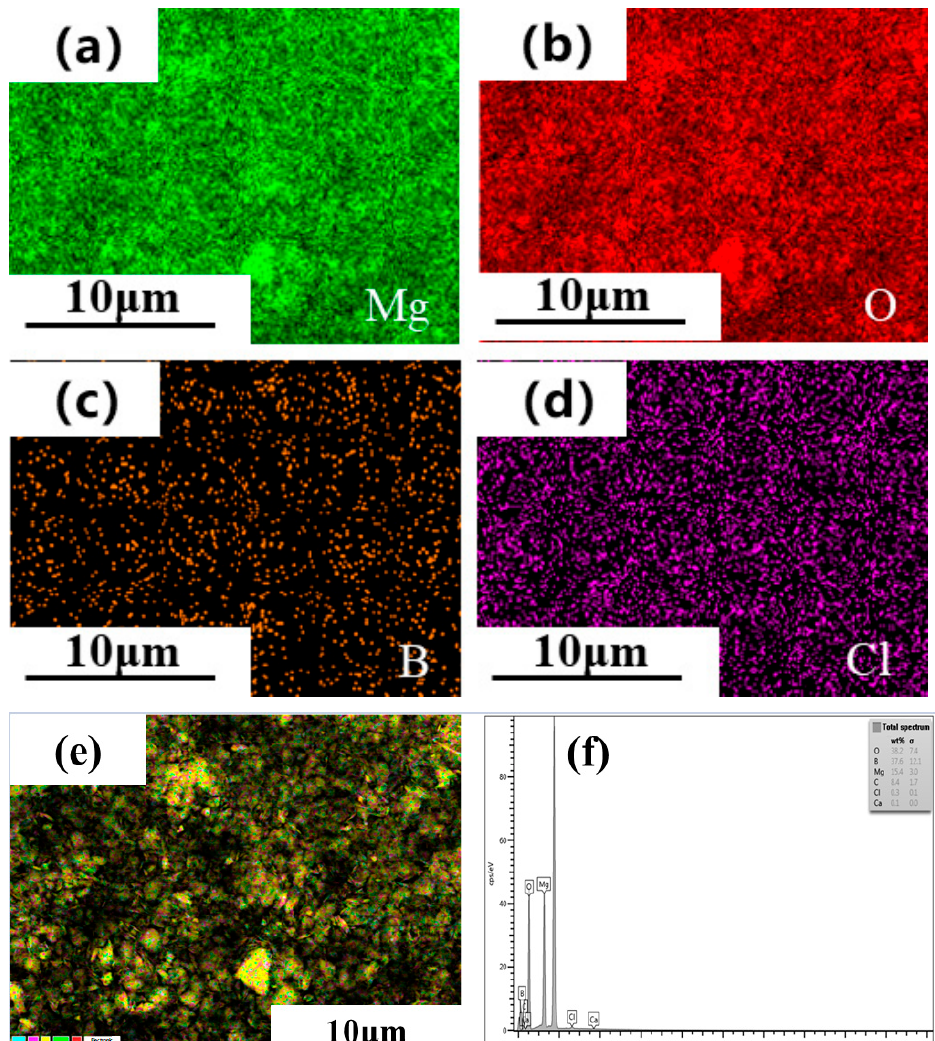
Figure 3. EDS spectrum of magnesium residue: ( a ) Mg; ( b ) O; ( c ) B; ( d ) Cl; ( e ) EDS elemental maps of major elements; ( f ) EDS spectrum.